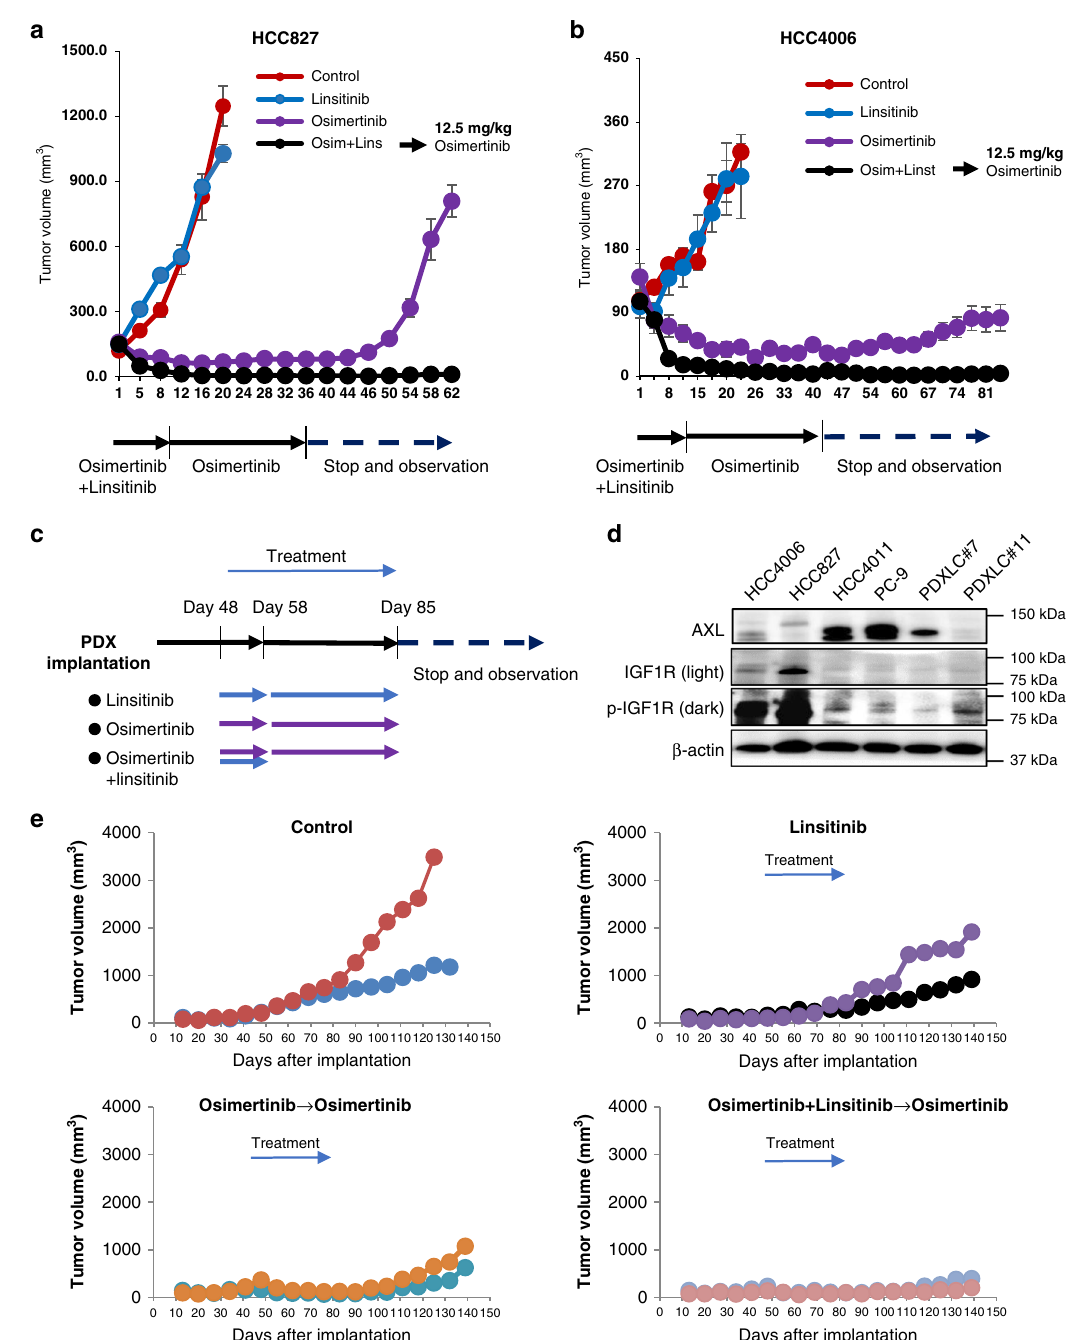
Fig. 7 Transient combination of linsitinib with osimertinib cured AXL-low tumors in vivo. The mice with HCC827 ( a )- or HCC4006 ( b )-cell line-derived xenograft (CDX) tumors were treated with vehicle (control: n = 4 mice), linsitinib 50 mg/kg ( n = 4 mice), osimertinib 12.5 mg/kg ( n = 5~6 mice), or linsitinib 50 mg/kg plus osimertinib 12.5 mg/kg ( n = 5 mice), administered by oral gavage for 10 days. Next, the groups administered osimertinib and linsitinib plus osimertinib were treated with osimertinib 12.5 mg/kg daily for an additional 25 days. Thereafter, the treatment was terminated and tumor regrowth was evaluated by day 62. Tumor volumes were measured over time from the start of treatment (mean ± s.e.m). c Treatment schedule for the PDX model. Forty-eight days after implantation of PDX tumors, the mice with PDX tumors were treated with vehicle (control), linsitinib 50 mg/kg, osimertinib 12.5 mg/kg, or linsitinib 50 mg/kg plus osimertinib 12.5 mg/kg, administered by oral gavage for 10 days. Next, groups administered osimertinib and linsitinib plus osimertinib were treated with osimertinib 12.5 mg/kg daily for an additional 27 days. The linsitinib group was treated with linsitinib 50 mg/kg daily for an additional 27 days. Thereafter, the treatment was terminated and tumor regrowth was evaluated by day 140. d Lysates of cell lines and PDXs were analyzed by western blotting. Data shown are representative of two independent experiments. e PDX LC#11 ( n = 2 mice/group) were treated as shown in ( c